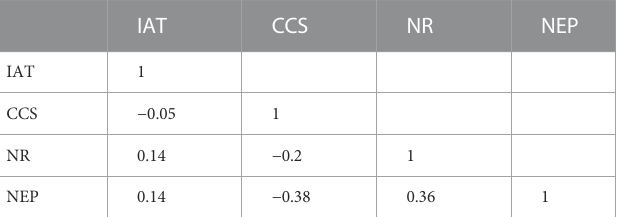
TABLE 1 Correlation table of the four environmental attitudes measures. Computed on the untranformed CCS